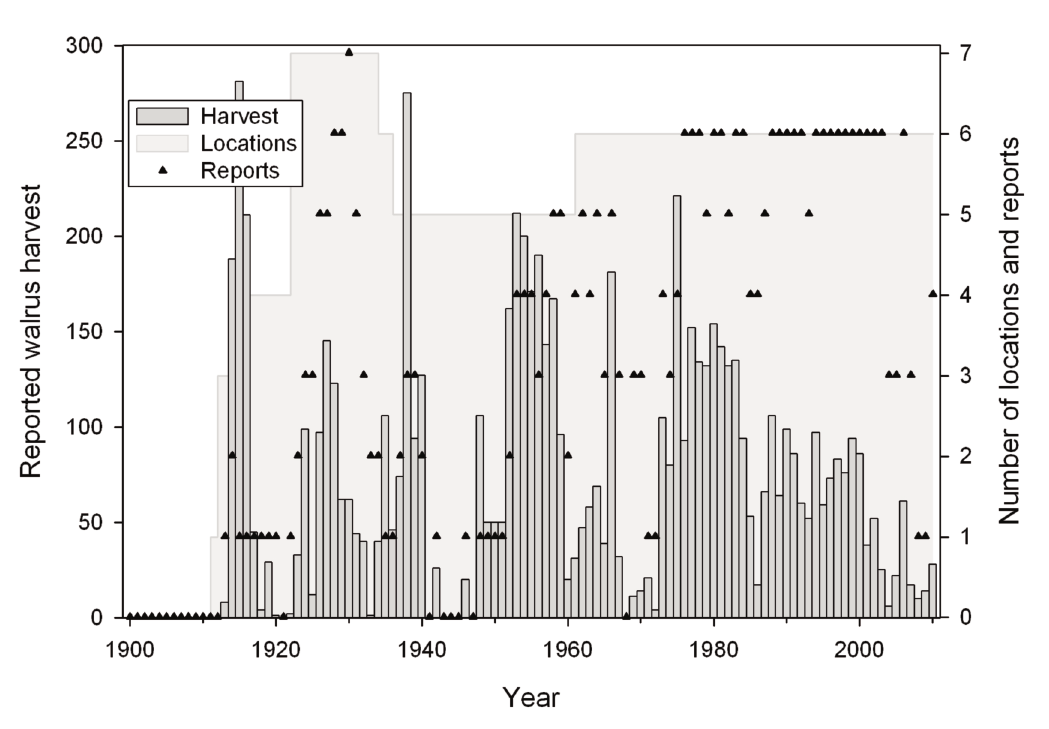
Fig. 22. Catches by Inuit and shore-based traders, and community reporting rates, from the South and East Baffin (SEB) stock of the Canadian Central Arctic walrus population, 1900–2010. Recent sport hunts not